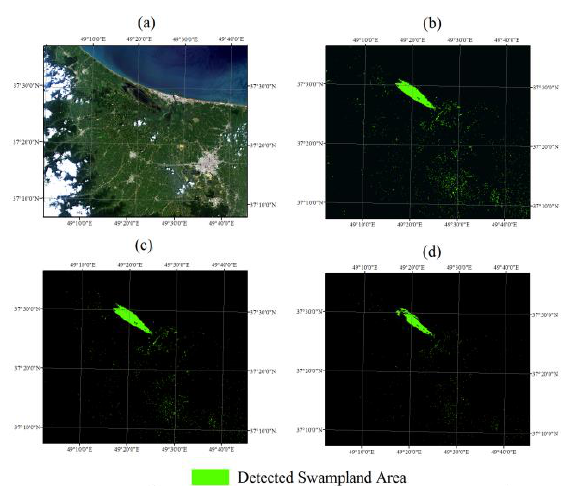
Figure 4. Applying different Δ value for Anzali swampland in Gilan provinces of the survey region. (a) RGB image, (b) Δ=- 0.3, (c) Δ= -0.4, (d) Δ=